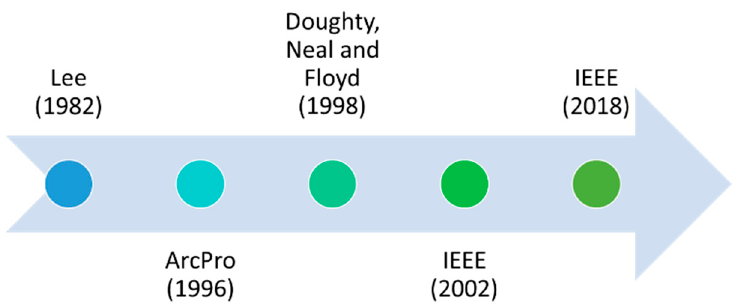
Figure 1. Electric arc incident energy estimation methods timeline.